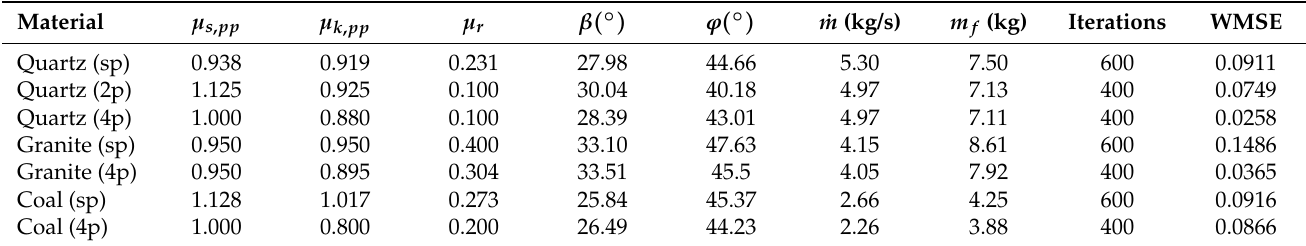
Table 7. Results of optimization of friction parameters through Draw Draw Test DEM simulations.